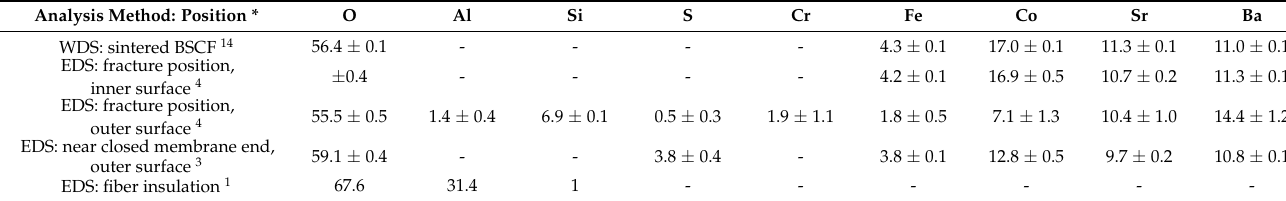
Table 3. Mean values and standard deviation of EDS and WDS analysis in mol%.